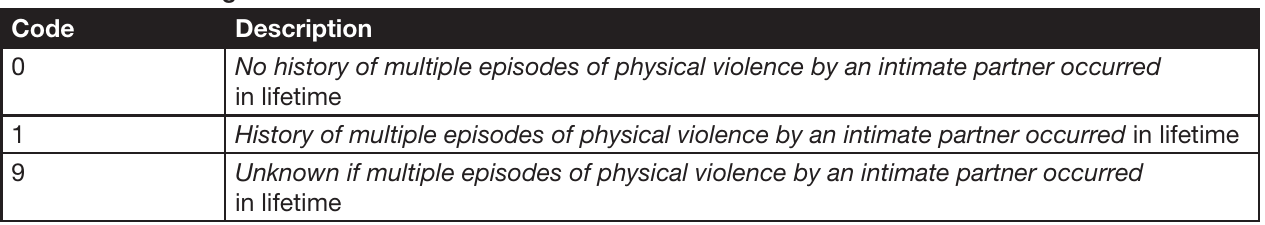
INTIMATE PARTNER VIOLENCE: UNIFORM DEFINITIONS AND RECOMMENDED DATA